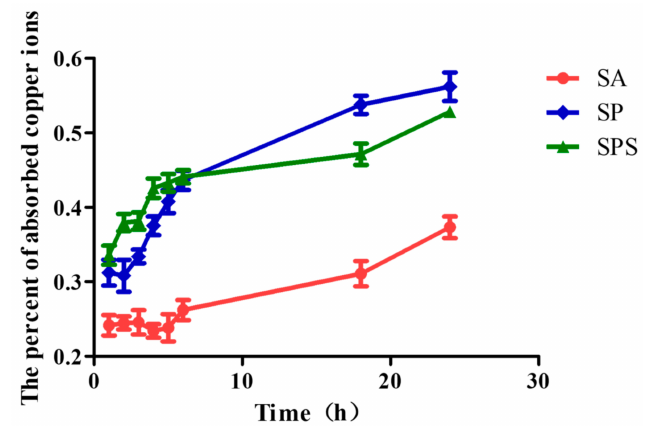
Figure 6. The ability of the SPS, SP and SA hydrogel spheres to absorb copper ions at pH 8.3 (mean ± SD, n = 5).